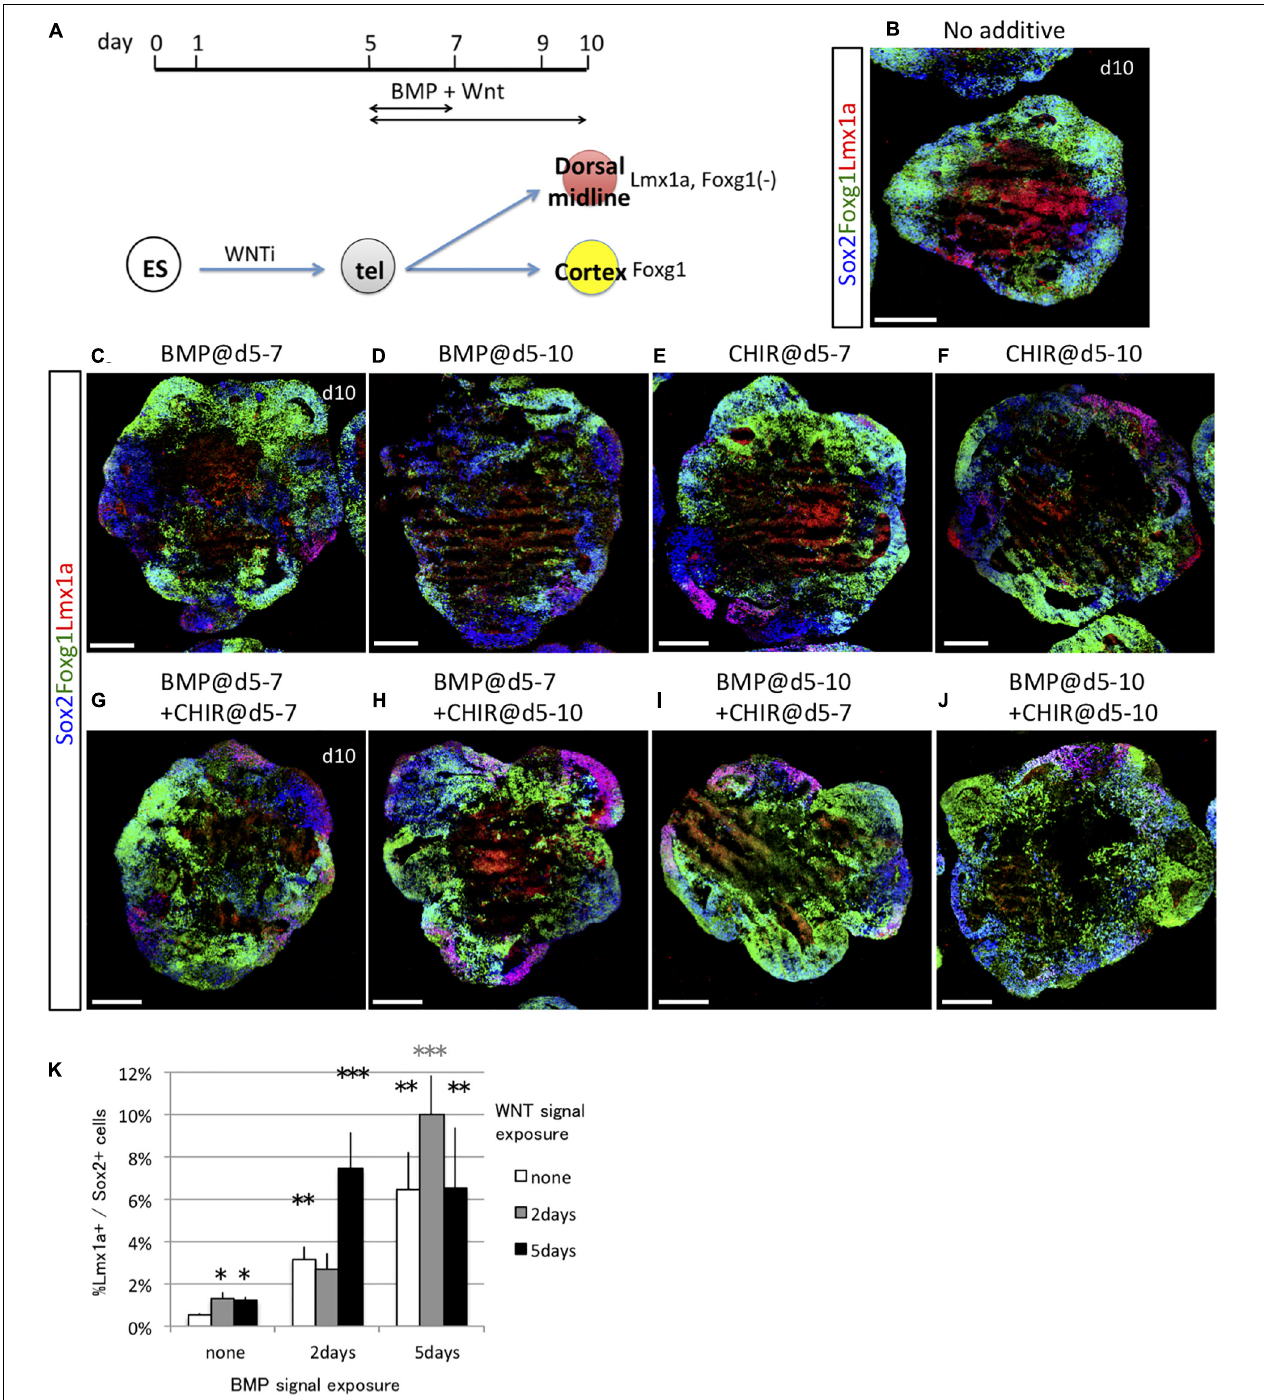
FIGURE 6 | Dorsal midline tissues were induced by timed BMP and WNT exposure. (A) Schematic of differentiation strategy for dorsal midline tissues and cortex. (B–F) Using the 3D culture, we assessed the optimal time window for 2 days (days 5–7) or 5 days (days 5–10) of BMP signal (BMP4 recombinant protein) or WNT signal (CHIR) exposure to induce dorsal midline tissues. Foxg1::venus cell aggregates cultured with no cues (B) or with BMP4 during days 5–7 and days 5–10 (C,D) , with CHIR during days 5–7 and 5–10 (E,F) . Images show Foxg1::venus fluorescence (green) and immunostaining for Lmx1a (red) and Sox2 (blue). (G–J) We examined the synergistic effect of BMP and WNT signals in combination for 2 days (days 5–7) or 5 days (days 5–10). Scale bars, 200 µ m. (K) Proportion (%) of Lmx1a + cells among Sox2 + cells. Greater proportion (%) of Lmx1a + cells among Sox2 + cells indicates that WNT signaling enhances the dorsalizing effect of BMP. Expressed as mean ± SEM ( N = 3). * P < 0.05, ** P < 0.01, *** P < 0.001.